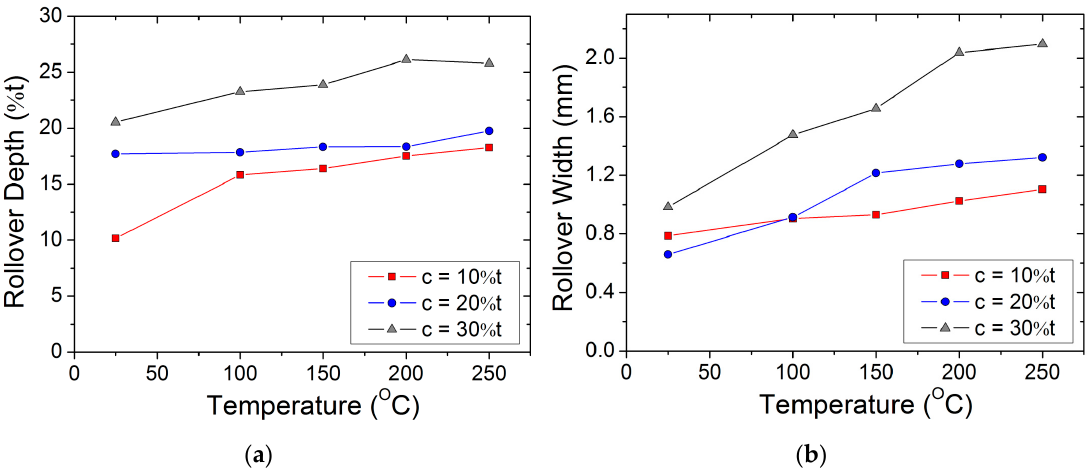
Figure 6. ( a ) Variation of the rollover depth (expressed as a percentage of the workpiece thickness) with temperature for various punch–die clearances; ( b ) variation of the rollover width with temperature for various punch–die